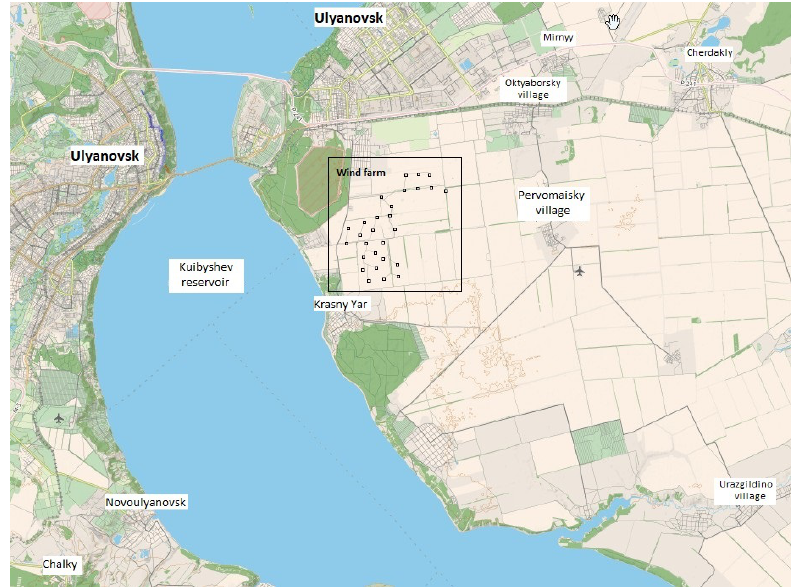
Figure 2. Ulyanovsk Wind Farm (photo from [46]).